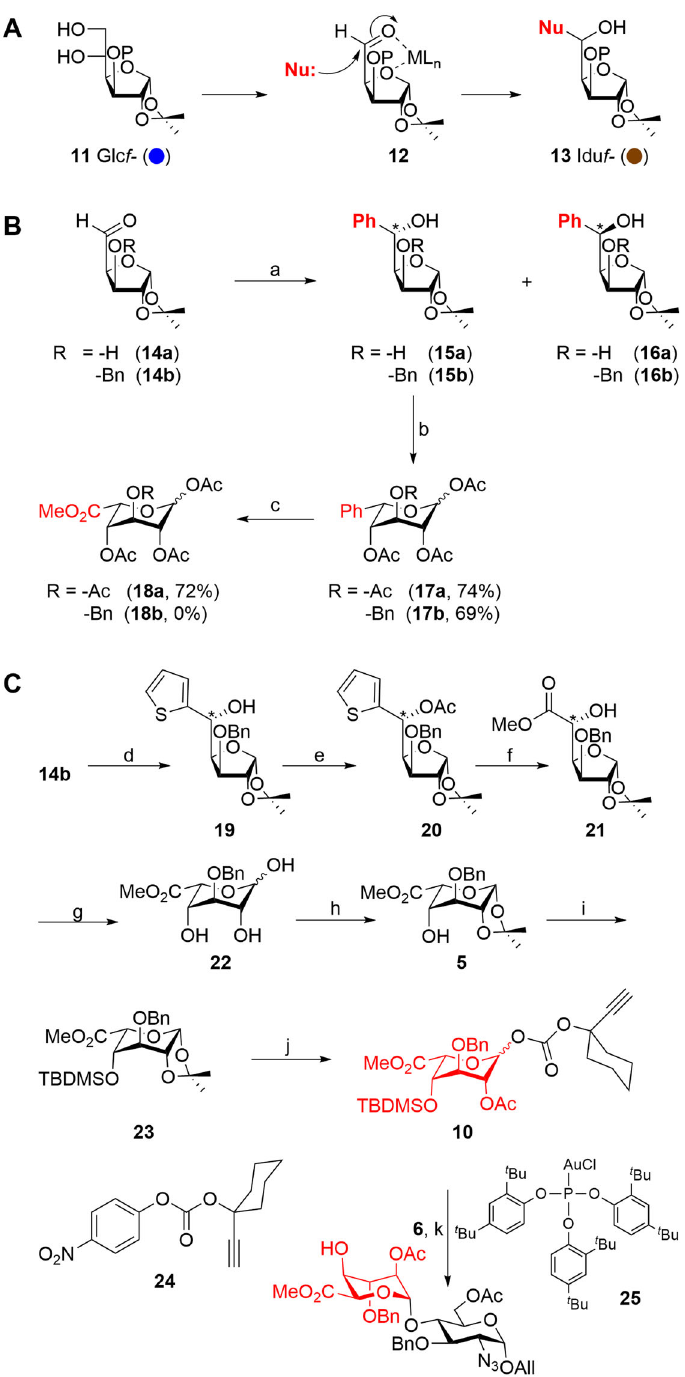
Fig. 2 Strategy for the synthesis of iduronic acid (A), synthesis of iduronic acid (B), and synthesis of desired iduronic acid building block (C). Reagents. a PhMgBr, THF, RT, 3 h, 85% ( 15a : 16a = 10:1), 83% ( 15b : 16b = 12:1); b (i) TFA-H 2 O (9:1), 25 °C, 15 min, (ii) Ac 2 O, pyridine, DMAP(cat), 2 h, 17a : 74%, 17b : 69%; over two steps; c RuCl 3 ·3H 2 O (5 mol%), NaIO 4 (8 eq.), CCl 4 – CH 3 CN-H 2 O (1:1:1.5), then K 2 CO 3 , CH 3 I, DMF, 25 °C, 8 h, 18a : 72%, 18b : 0% over two steps. d 2-Thienylmagnesium bromide, Et 2 O, 25 °C, 3 h, 89% ( 19a : 19b : 10:1); e Ac 2 O, DMAP, 1 h, 25 °C, 95%; f (i) RuCl 3 .3H 2 O (5 mol%), NaIO 4 (8 eq.), hexane-ethylacetate-H 2 O (1:3:4), then K 2 CO 3 , CH 3 I, DMF, 25 °C, 8 h, 74%; over two steps; (ii) NaOMe, MeOH, 25 °C, 30 min, 94%; g TFA-H 2